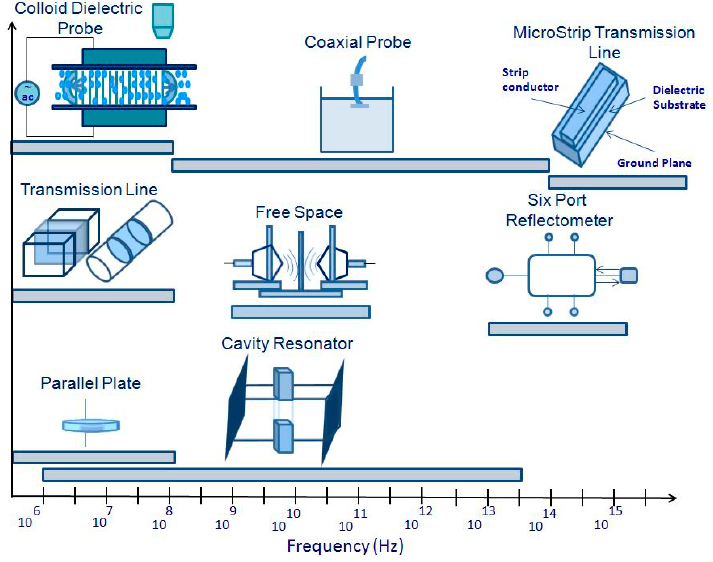
Figure 5. Dielectric properties techniques used for the agri-food characterization versus the frequency